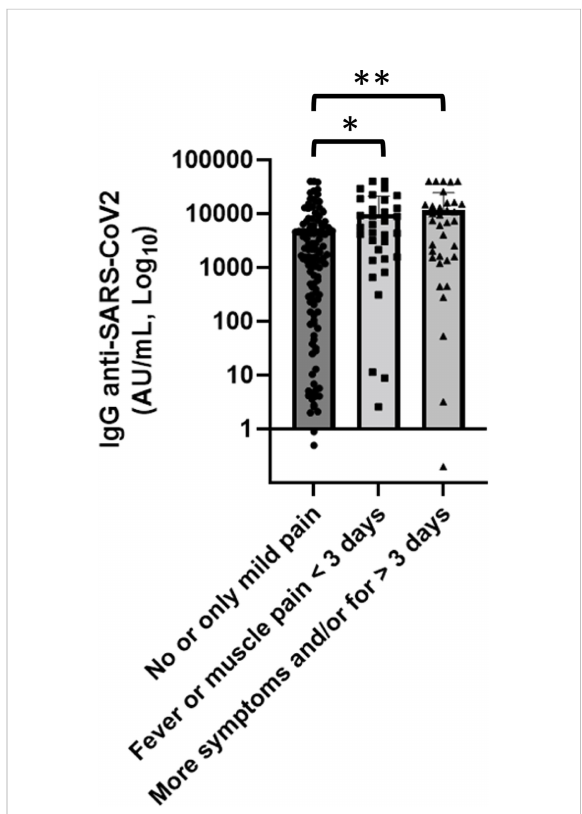
FIGURE 7 Association of anti-SARS-CoV-2 IgG concentrations with side effects. Patients who experienced more symptoms showed anti- SARS-CoV-2 IgG titer greater than patients who did not report side effect or only mild pain. Differences assessed by one-way ANOVA test (p < 0.001), Bonferroni post-hoc test: (*) p < 0.05; (**) p < 0.005. Error bars correspond to standard deviation calculated from the mean of relative concentrations. Values below the black line correspond to anti-SARS-CoV-2 IgG lower than 10.0 AU/ml, and values of 0 AU/ml were not shown since the graph is on a log